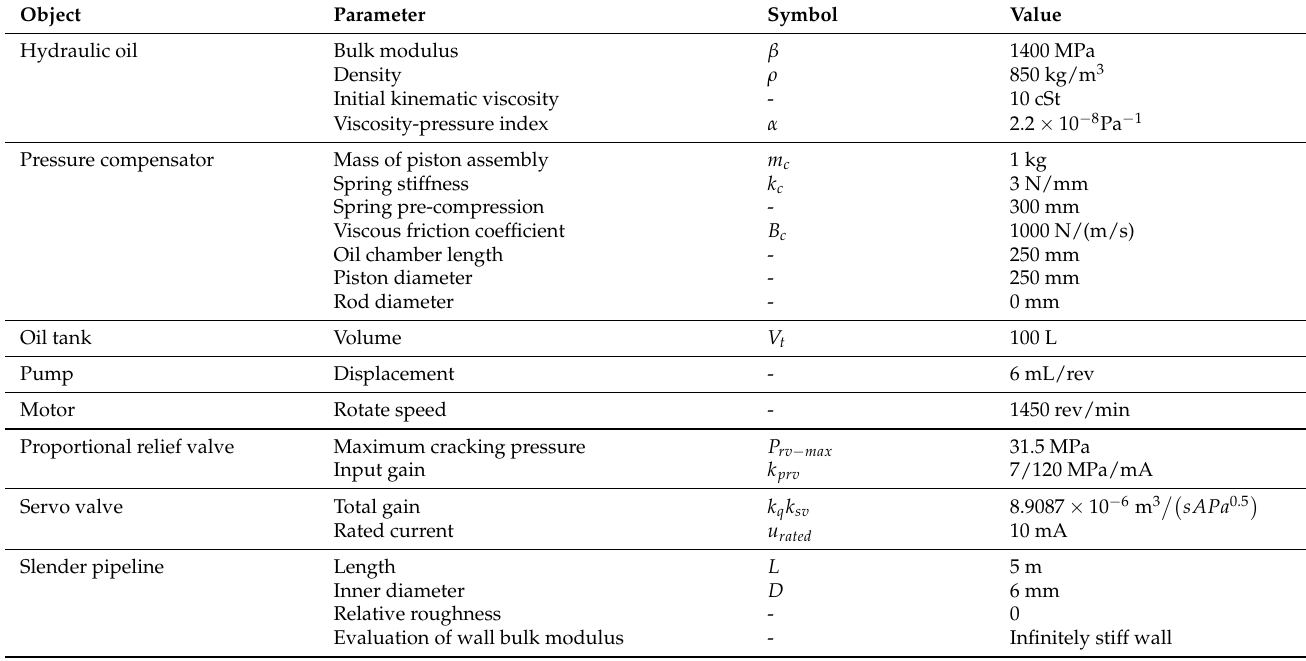
Table A2. Parameter